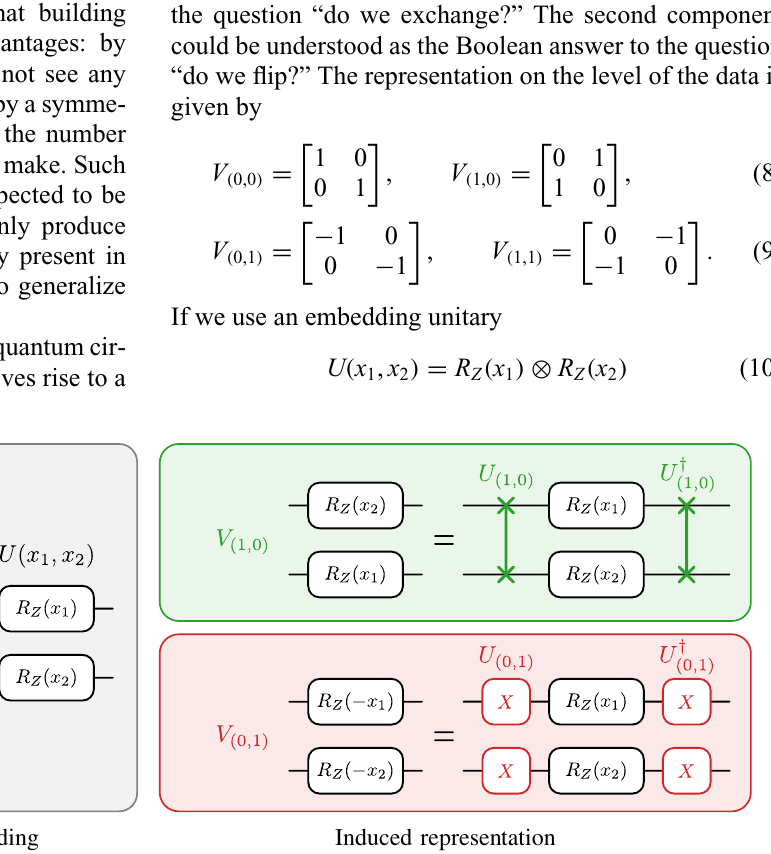
FIG. 2. Simple example of a classification problem with two features ( x 1 , x 2 ) that has a Z 2 × Z 2 symmetry generated by a flip about the axis x 1 = x 2 (green) and inversion about the center (red). Combining both operations yields a flip about the axis x 1 = − x 2 (purple). Together with the simple qubitwise embedding of the coordinates, these induce a representation of Z 2 × Z 2 generated by a SWAP operation of the two qubits and a simultaneous application of Pauli X on the two qubits.